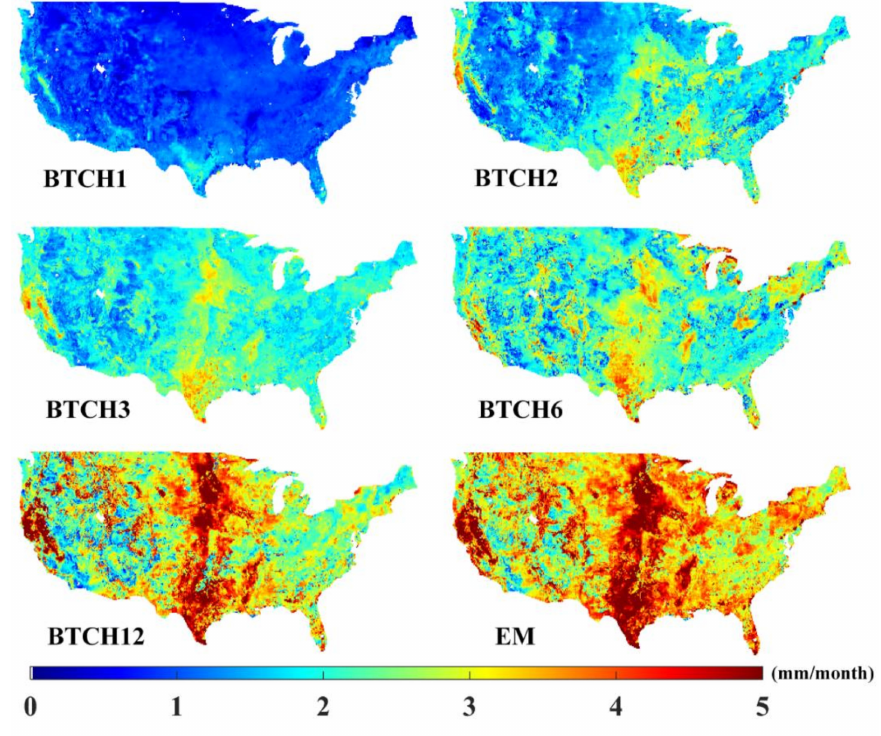
Figure 14. The uncertainties of evapotranspiration (ET) products from the ensemble mean (EM) and Bayesian-based three-cornered hat (BTCH) methods with di ff erent time windows over the contiguous United